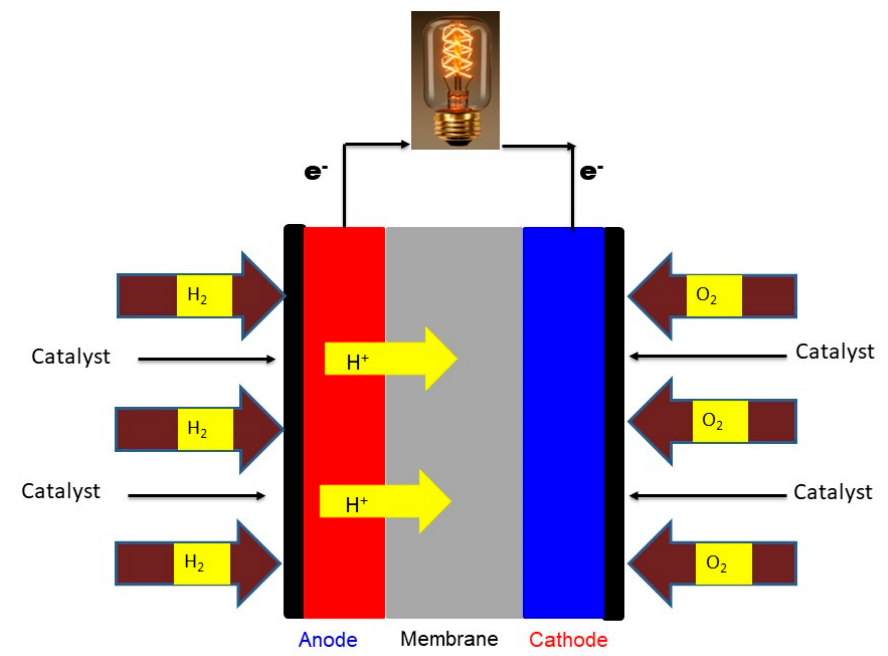
Figure 2. Fuel cell assembly illustration.